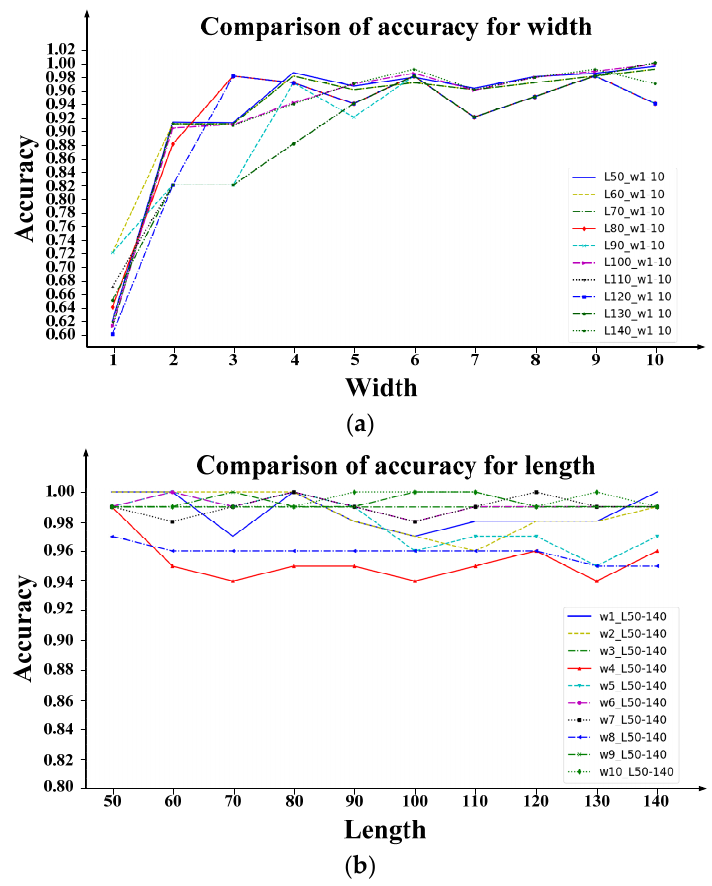
Figure 12. Comparison of accuracy for result of mini-crack measurement. ( a ) Width; ( b ) Length.